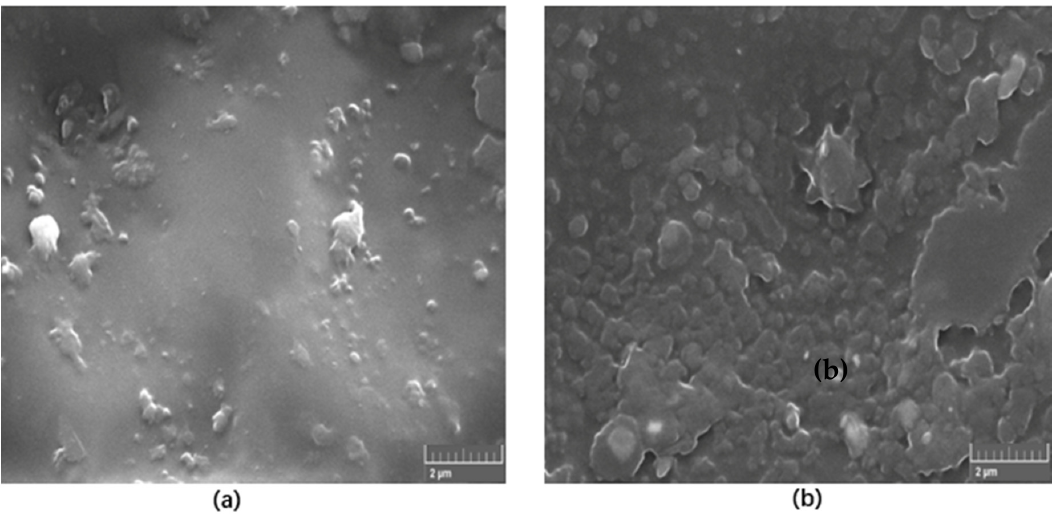
Figure 4. SEM images of ( a ) 1 wt.% and ( b ) 5 wt.% self-cured PMMA / h-BN nanocomposites formed under ultrasonic mixing.